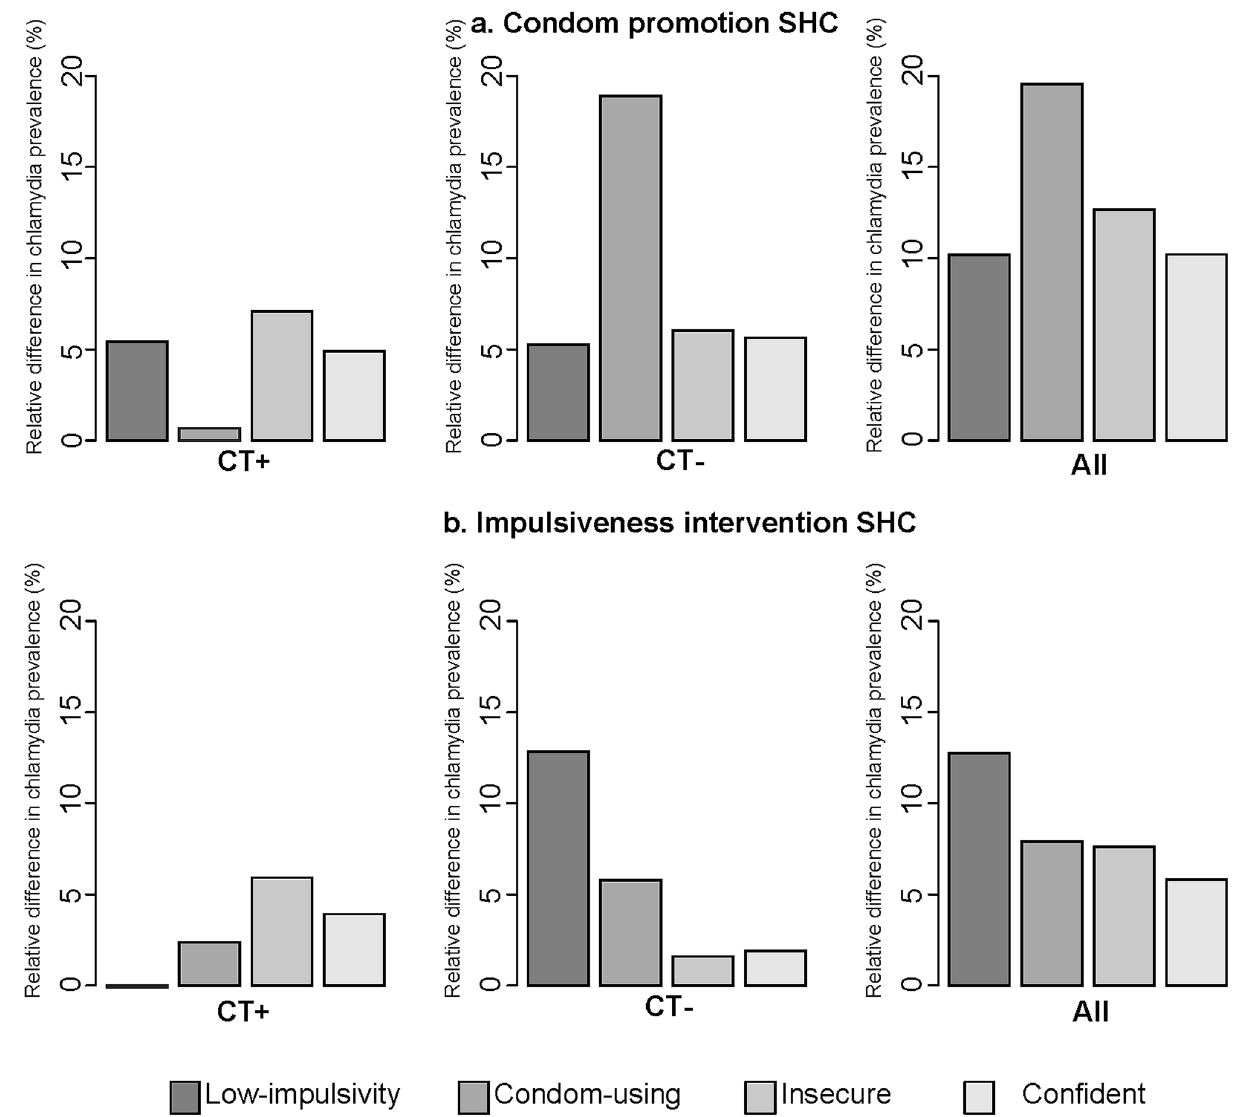
Figure 2. Impact on chlamydia prevalence five years after the introduction of condom promotion at SHC (a) , and of the impulsiveness intervention at SHC (b) with differential intervention effects, targeted at only at individuals who tested chlamydia positive (CT +), only at individuals who tested chlamydia negative (CT−), and targeted at all tested